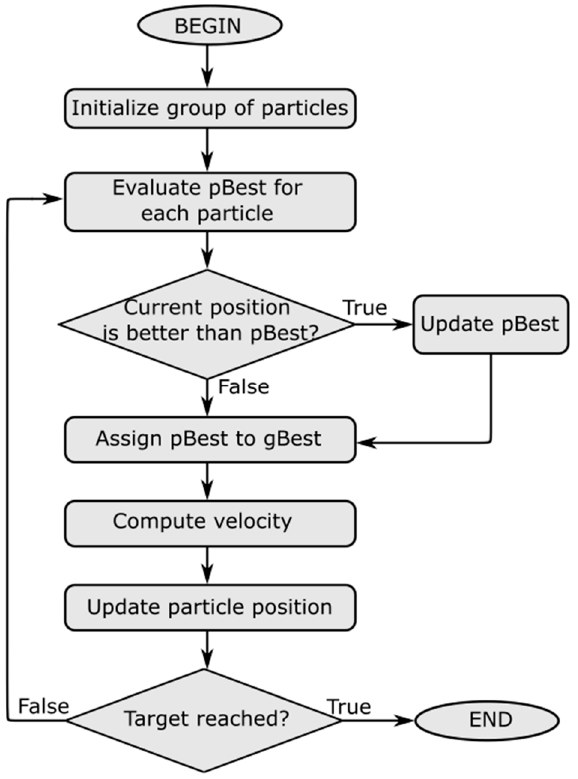
Figure 3. The Particle Swarm Optimization (PSO) algorithm.